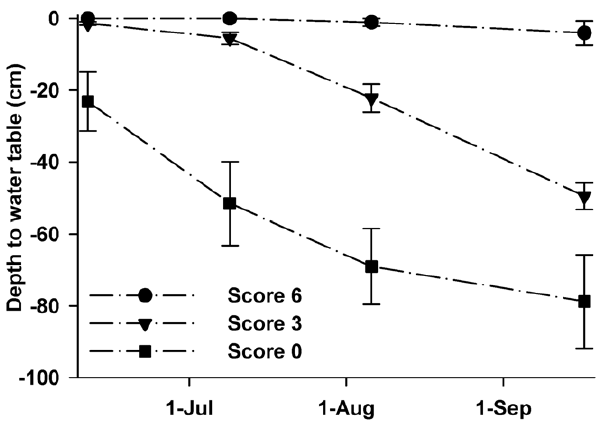
Figure 3. Water table dynamics. Mean depth to water table by meadow hydrology score for 10 meadows in the High Sierra Ranger District, Sierra National Forest, California, USA, during 2008. Hydrologic scale ranged from 0 to 6, with 0 representing drier sites and 6 representing the wettest sites. Water tables diverged over the summer: wet sites (score 6) experienced a mean seasonal drawdown of 4 cm while drier sites (score 0) experienced an mean seasonal drawdown of 79 cm. Vertical bars represent 6 1 SE.